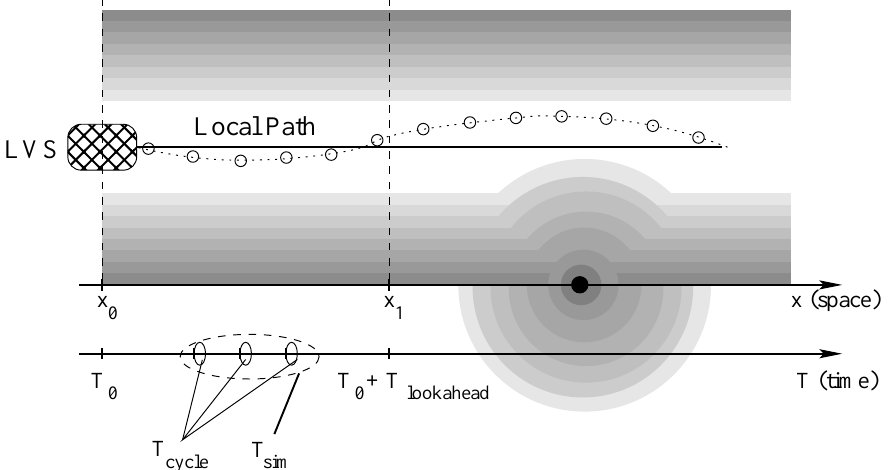
Figure 2. A graphical representation for our terms on a standard background occupancy grid map. Black areas represent obstacles which must be avoided at all costs. Gray tones become darker closer to black areas to represent an increasing level of danger. The vehicle position is represented at time T 0 in horizontal position x 0 . The current vehicle direction is represented by the horizontal black line, whereas the local path (indicated by the dotted line) is computed to maintain the vehicle at the center of the white area, thus minimizing the risk of collision. Dots on the local path represent position samples. The algorithm will target the terminal states computed at time T 0 + T lookahead and horizontal position x 1